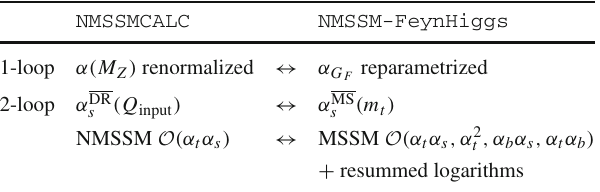
Table 1 Calculational differences between the original versions of NMSSMCALC and NMSSM-FeynHiggs as used for this comparison. The values applied for the electromagnetic and strong coupling con- stants are stated, where α G denotes the electromagnetic coupling con- F stant calculated from the Fermi constant